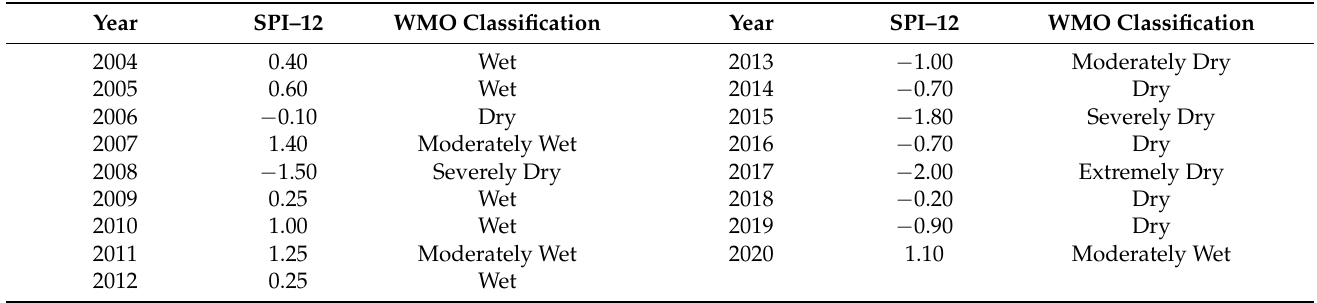
Table 2. Approximate SPI–12 values at Yongdam watershed [34] and its WMO classification [33].